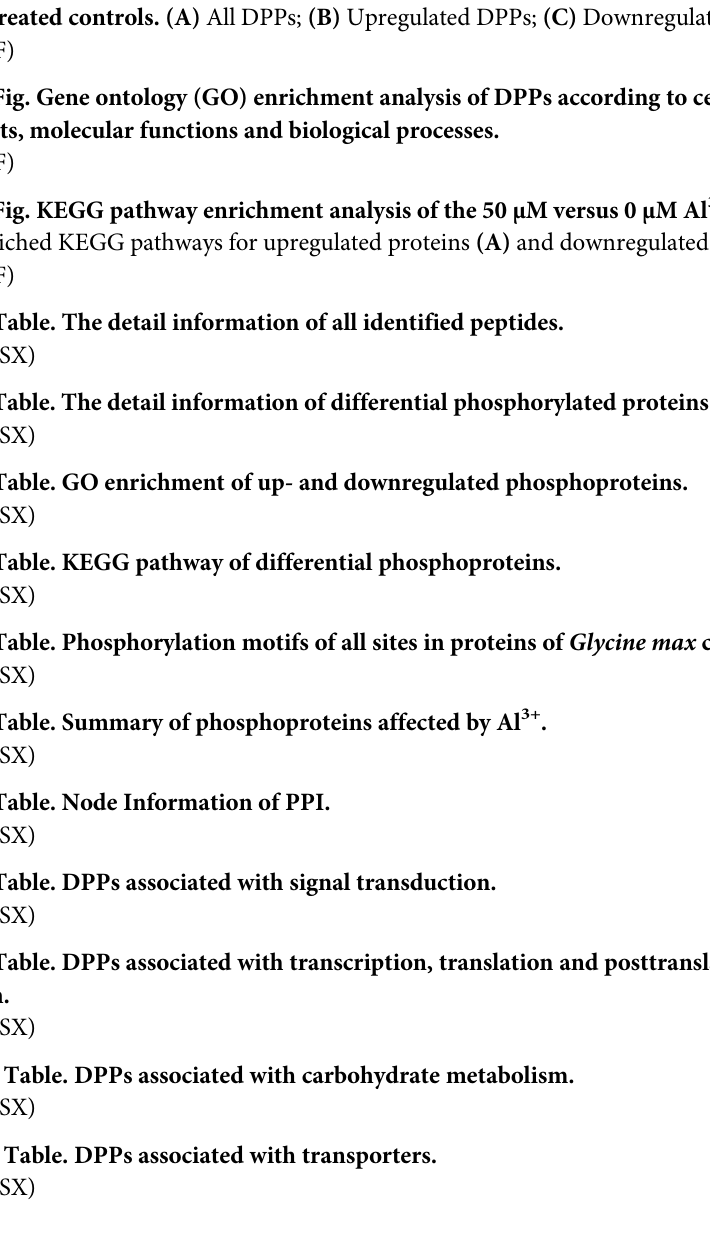
S1 Fig. Quality control validation of mass spectrometry data. (A) Volcano map of the error rate distribution for mass spectrometry; (B) Length distribution of the phosphorylated pep- tides. S2 Fig. GO function classifications of differentially phosphorylated proteins (DPPs) in Al 3 + -treated plants compared with untreated controls. (A) Biological process; (B) Cellular com- ponent; (C) Molecular function. S3 Fig. Subcellular localization prediction of DPPs in Al 3+ -treated plants compared with untreated controls. (A) All DPPs; (B) Upregulated DPPs; (C) Downregulated DPPs. S4 Fig. Gene ontology (GO) enrichment analysis of DPPs according to cellular compo- nents, molecular functions and biological processes. S5 Fig. KEGG pathway enrichment analysis of the 50 μ M versus 0 μ M Al 3+ treatments. Enriched KEGG pathways for upregulated proteins (A) and downregulated proteins (B) . S1 Table. The detail information of all identified peptides. S2 Table. The detail information of differential phosphorylated proteins and phosphosites. S3 Table. GO enrichment of up- and downregulated phosphoproteins. S4 Table. KEGG pathway of differential phosphoproteins. S5 Table. Phosphorylation motifs of all sites in proteins of Glycine max cv. Tamba. S6 Table. Summary of phosphoproteins affected by Al 3+ . S7 Table. Node Information of PPI. S8 Table. DPPs associated with signal transduction. S9 Table. DPPs associated with transcription, translation and posttranslational modifica- tion. S10 Table. DPPs associated with carbohydrate metabolism. S11 Table. DPPs associated with